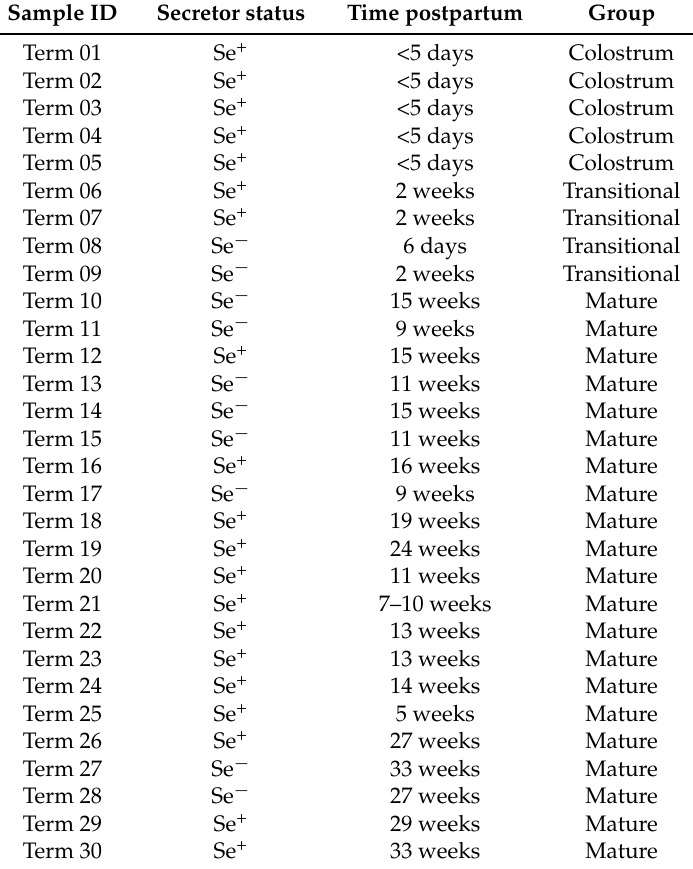
Table 2. Sample information from mothers of term